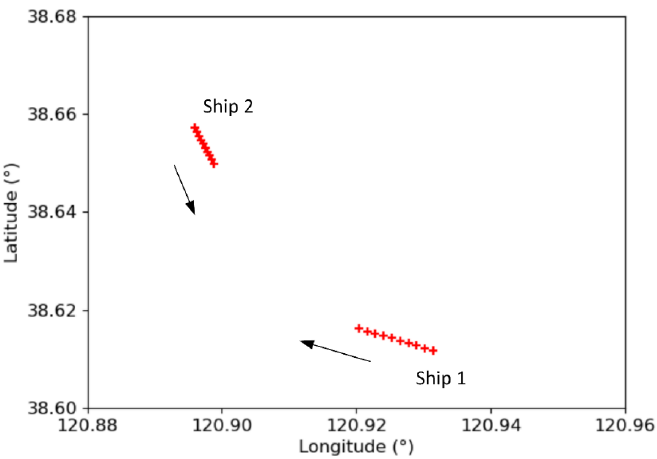
Figure 11. The trajectories of two crossing encountering ships for another 10 moments. Table 11. The danger sectors of another 10 moments in a crossing encountering scenario.